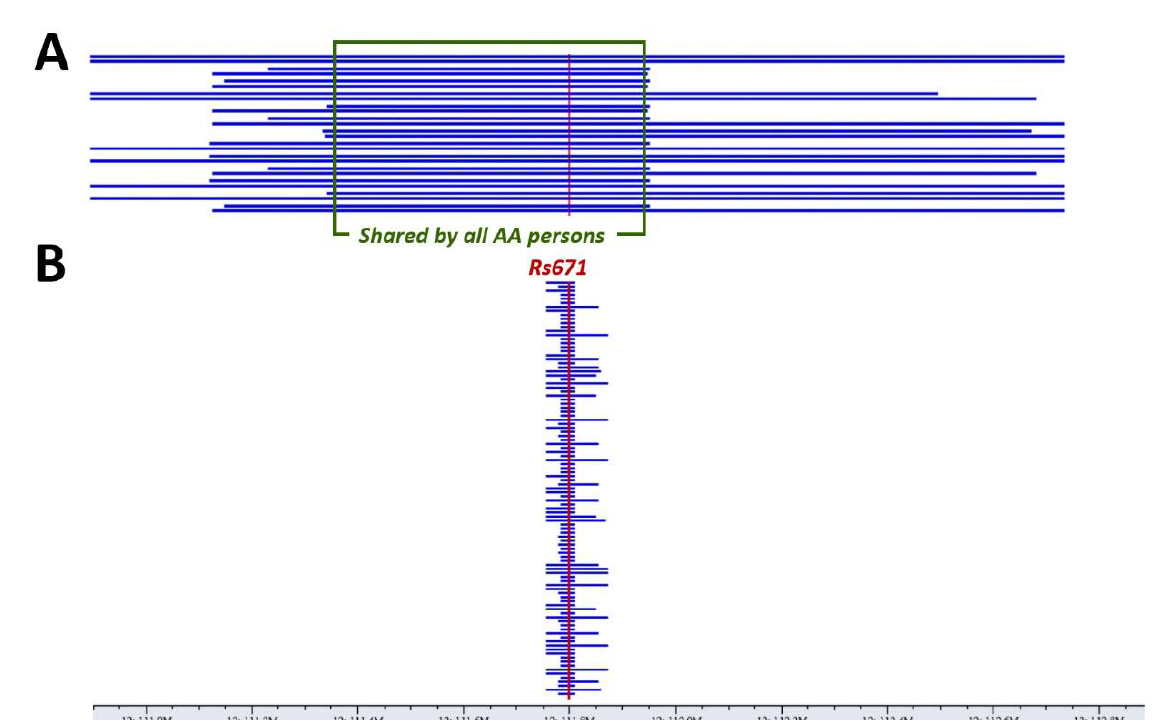
Figure 2. The haplotypes inferred in the vicinity of rs671 (Chr12:110,912,851-112,927,816), shown as blue horizontal lines. The vertical red lines depict the spot of rs671. ( A ) The rs671 “A”-allele-carrying haplotypes in persons with homozygous “AA” genotypes. Each person has two haplotypes shown as two consecutive blue horizontal lines (13 persons, 26 haplotypes). In each aligned genomic location of the blue horizontal lines, the nucleotide bases are identical, without exceptions. Within the green box, all persons have identical haplotypes encompassing 38 consecutive variants. ( B ) The rs671 “G”-allele-carrying haplotypes, calculated by using the same method as in ( A ), in persons with homozygous “GG” genotypes.